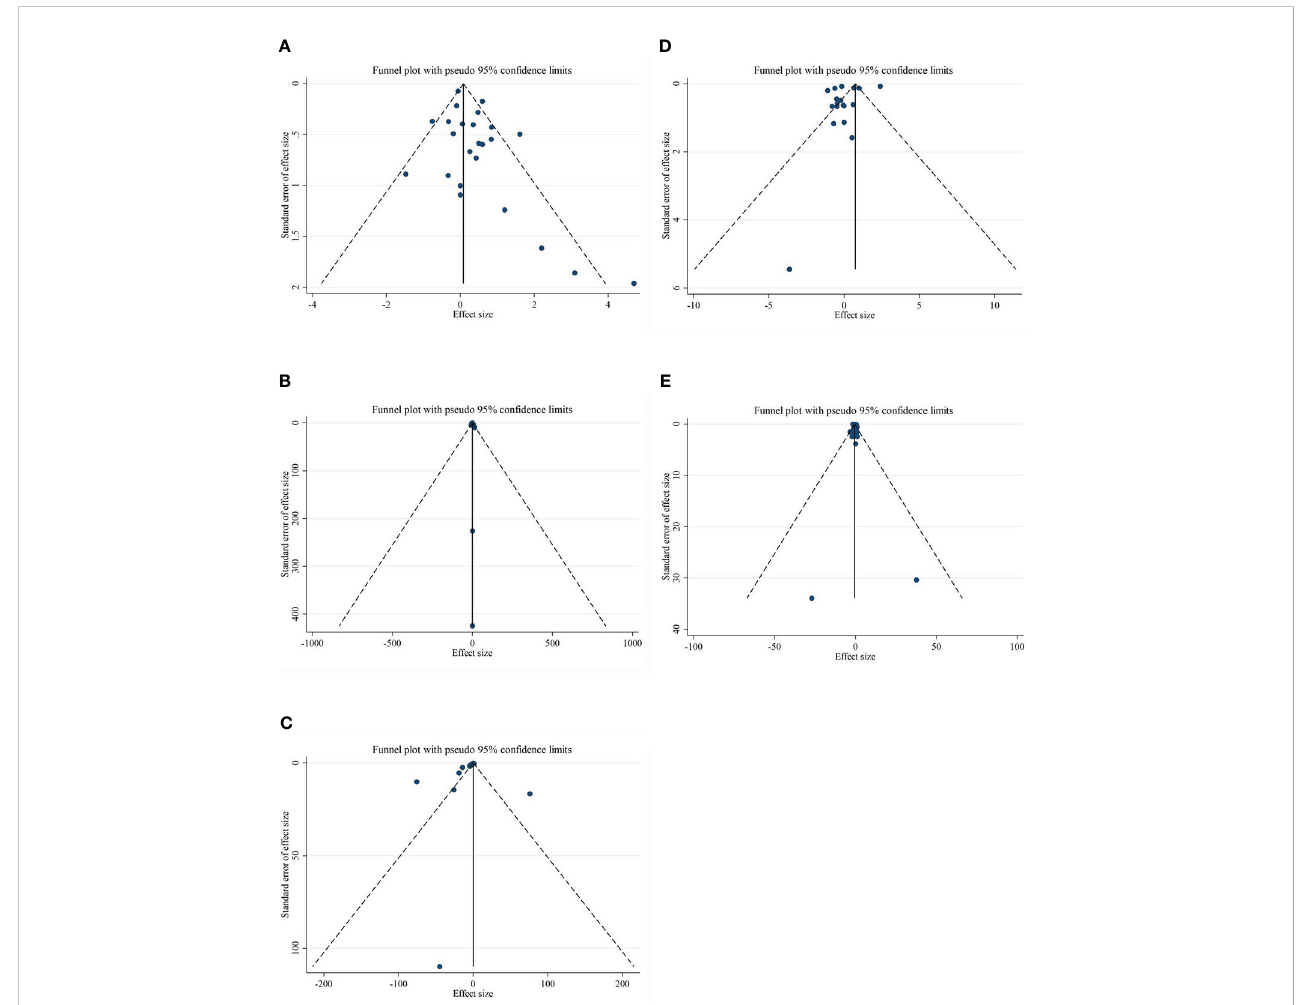
FIGURE 3 Funnel plots for the effect of CLA consumption on (A) CRP (mg/L), (B) IL-6 (pg/ml), (C) TNF- a (ng/ml), (D) adiponectin (µg/ml), and (E) leptin (ng/ml). Horizontal lines represent 95% CIs. Diamonds represent pooled estimates from random-effects analysis. WMD, weighted mean difference; CI, con fi dence interval; CLA, conjugated linoleic acid; CRP, C-reactive protein; IL-6, interleukin 6; TNF- a , tumor necrosis